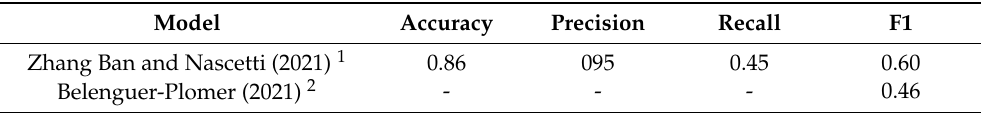
Table 4. Summary of benchmark study results for SAR based burn area detection 1 Based on the U-Net with Learning without forgetting with SAR based reference for the Sydney Fire (2019-2020); 2 Based on North American study area S1 satellites only. Model Accuracy Precision Recall F1